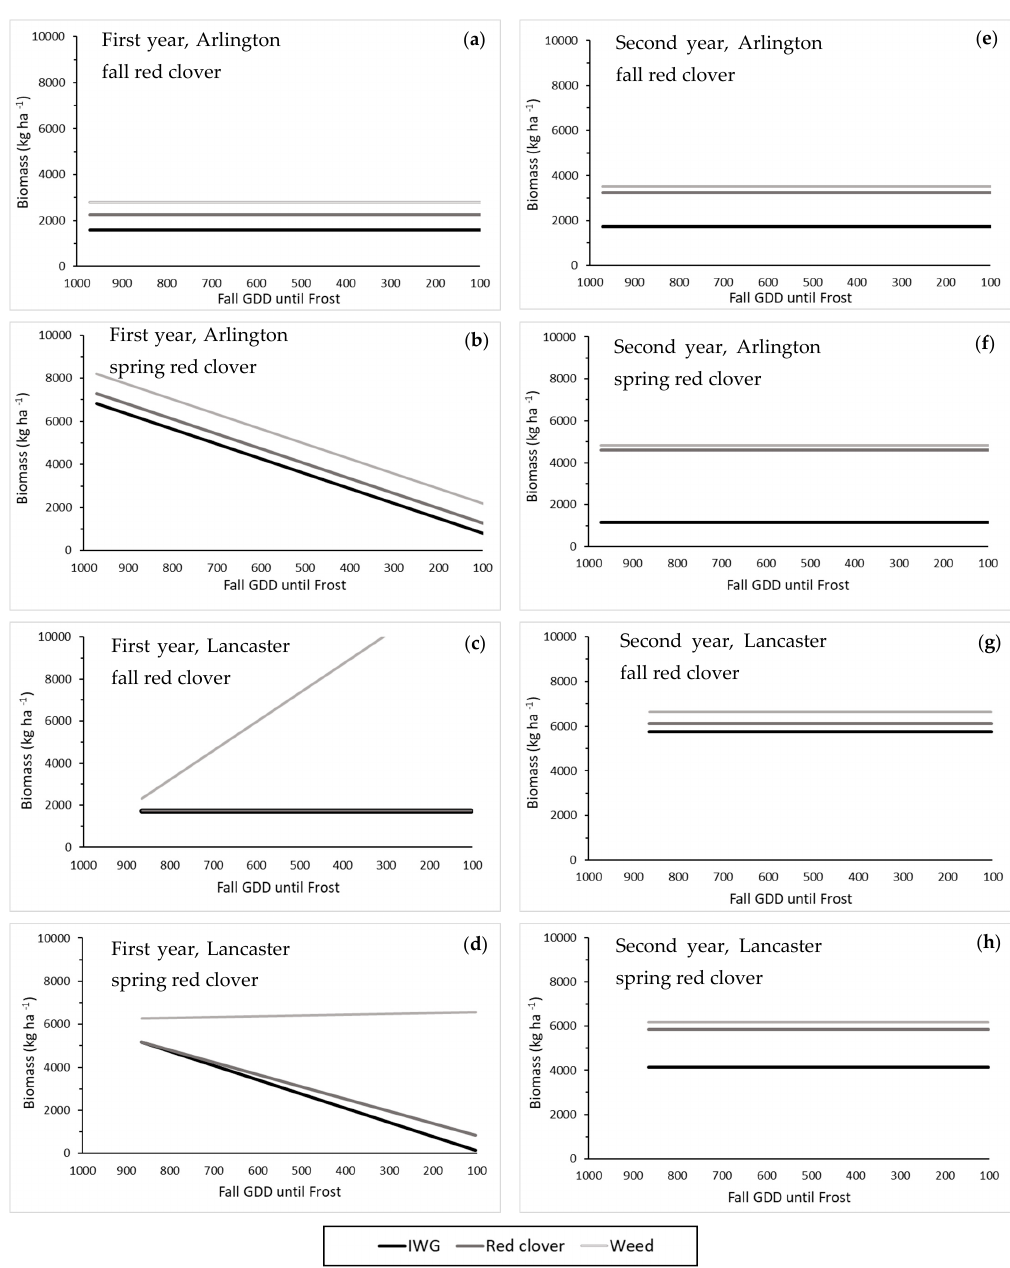
Figure 4. Stacked (i.e., cumulative) lines of estimated values from best fit models of summer Intermediate wheatgrass (IWG), red clover, and weed biomass in kg ha − 1 in the first year for ( a ) Arlington fall red clover, ( b ) Arlington spring red clover, ( c ) Lancaster fall red clover, and ( d ) Lancaster spring red clover, and in the second year for ( e ) Arlington fall red clover, ( f ) Arlington spring red clover, ( g ) Lancaster fall red clover, and ( h ) Lancaster spring red clover treatments. The first year linear equations and p -values are Arlington, spring red clover: IWG = 6.9x + 104.2 ( p < 0.01); Lancaster, fall red clover: Weed = − 13.8x + 12511 ( p = 0.01); and Lancaster, spring red clover: IWG = 6.6x − 550.9 ( p = 0.01), Red clover = − 0.9x + 798.1 ( p = 0.02), Weed = − 6.1x + 6366.5 ( p = 0.03). In panel ( c ), the maximum stacked value of biomass is not shown for consistency of graph axis. Note that lines are stacked, so the biomass of each species is represented by the distance between the lines (Red clover line = IWG + Red clover biomass; Weed line = IWG + Red clover + Weed